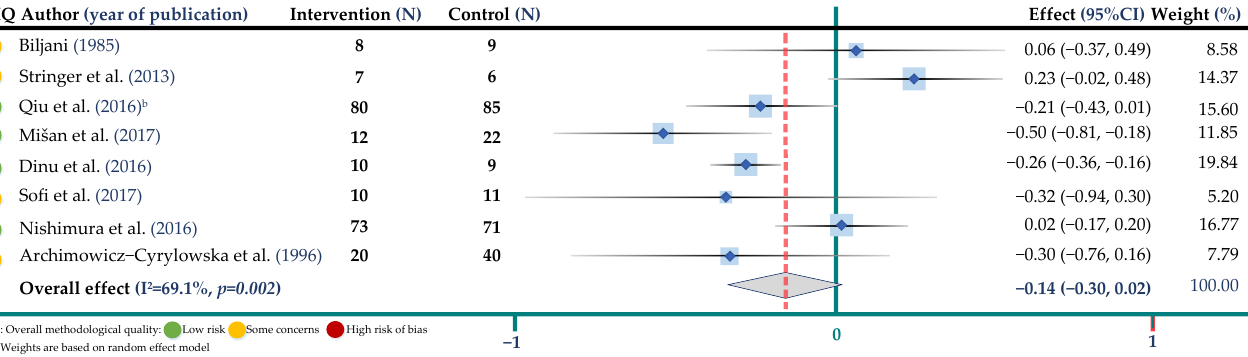
Figure 2. Meta-analysis on buckwheat supplementation and total cholesterol. b indicates the Qiu